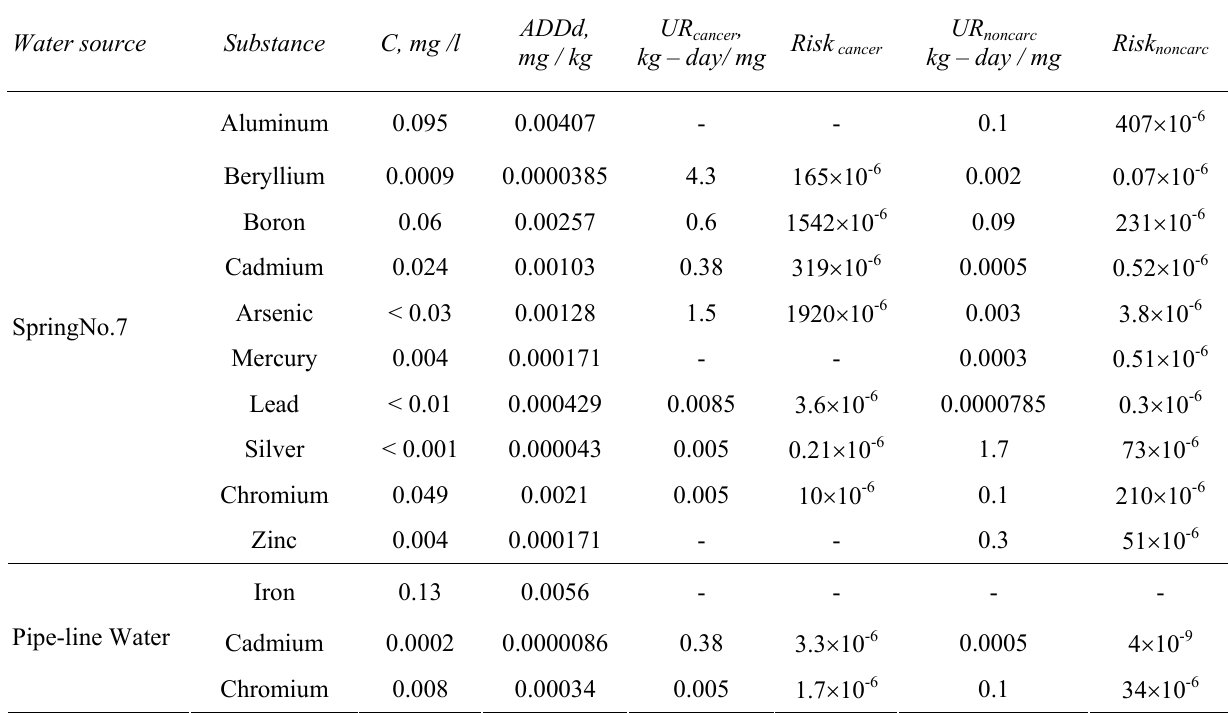
Table 2: Calculated carcinogenic and noncarcinogenic risk of groundwater Water